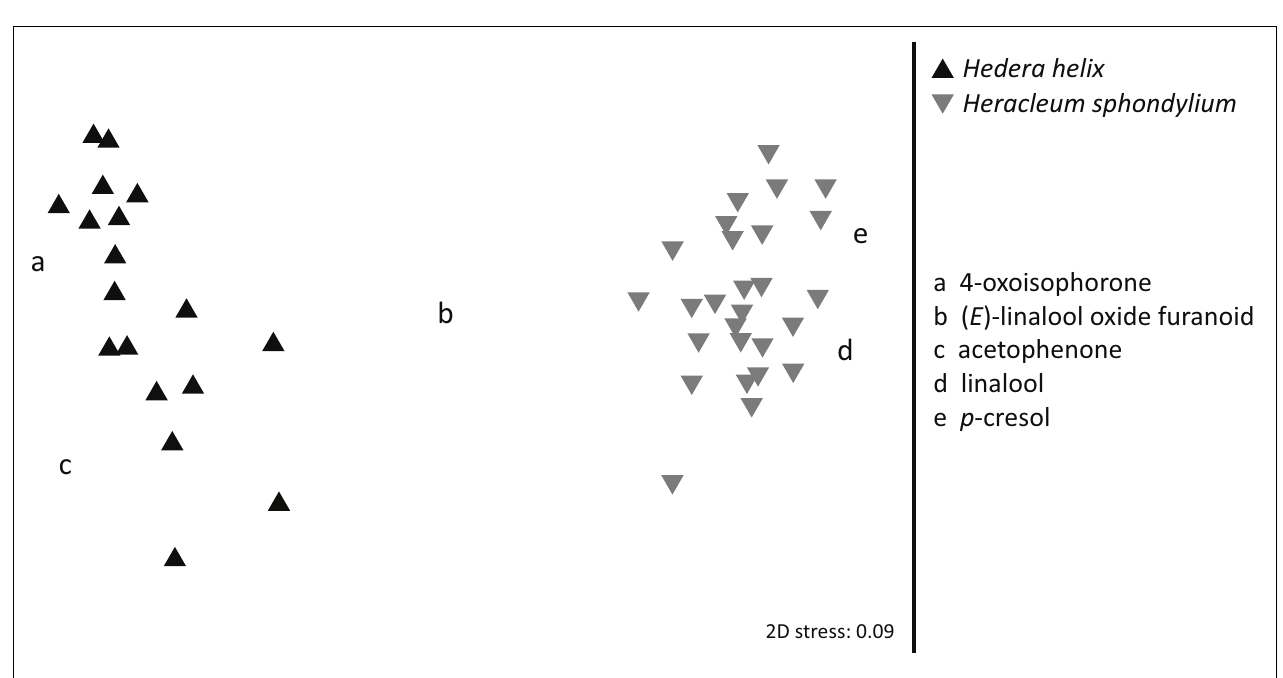
and 2-heptanone (7 ± 2%). The total amounts of